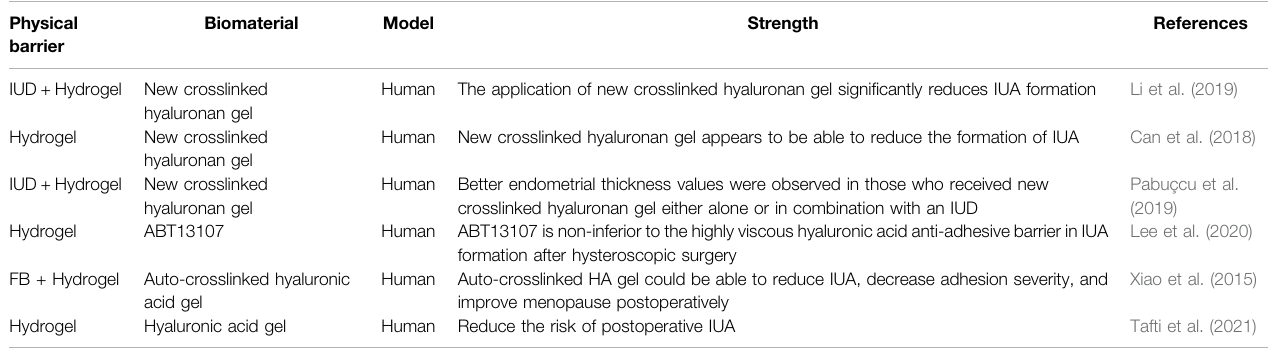
TABLE 1 | Summary of bioactive hydrogels as physical barriers used in